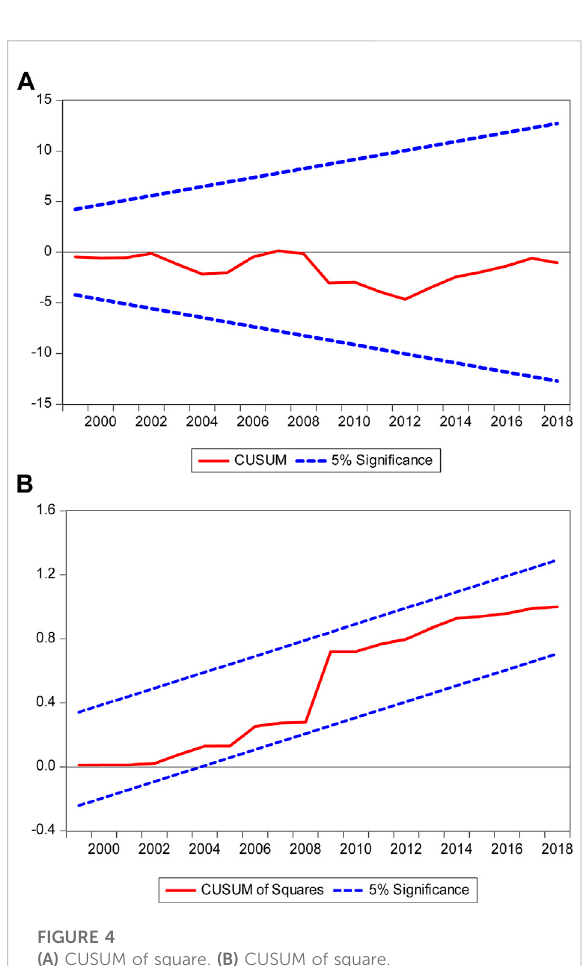
FIGURE 4 (A) CUSUM of square. (B) CUSUM of